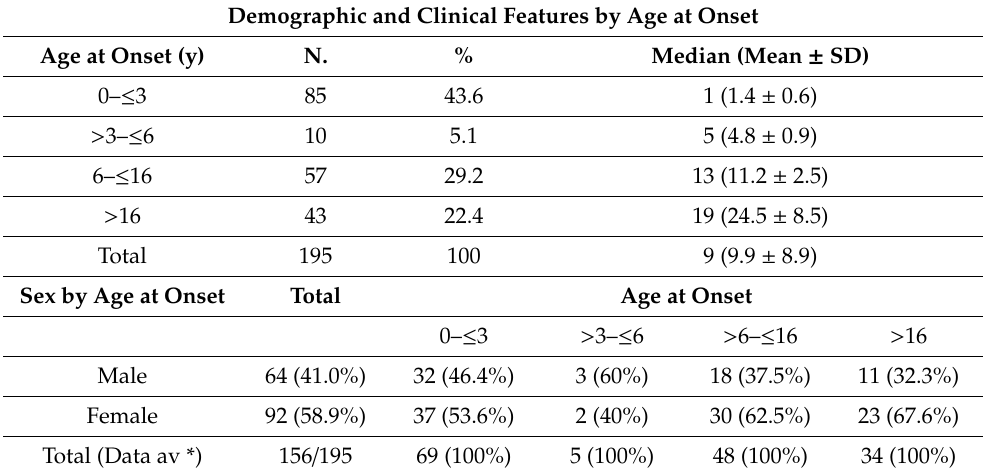
Table 1. Demographic and clinical features by age at